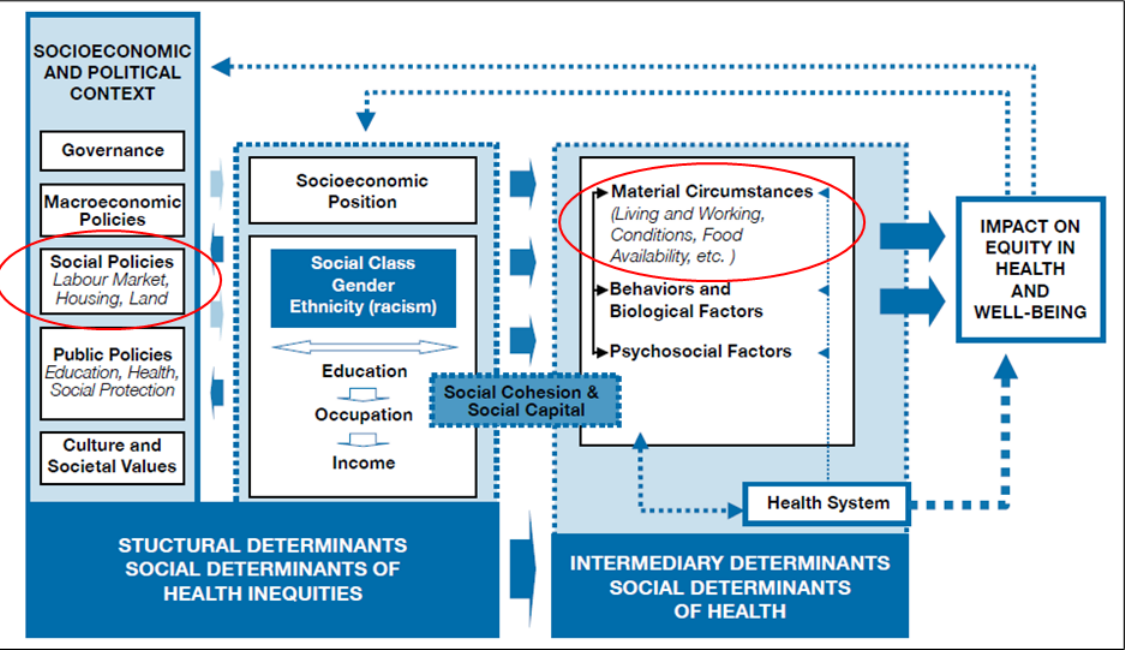
Figure 1. Conceptual framework showing the link between housing and health and well-being [12].